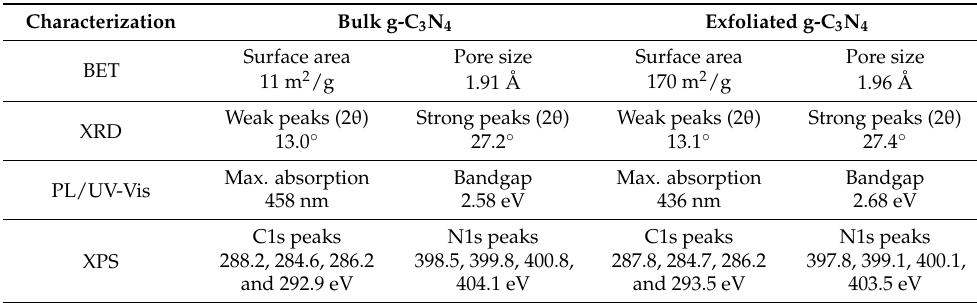
Table 2. Summary of characterization results [18].